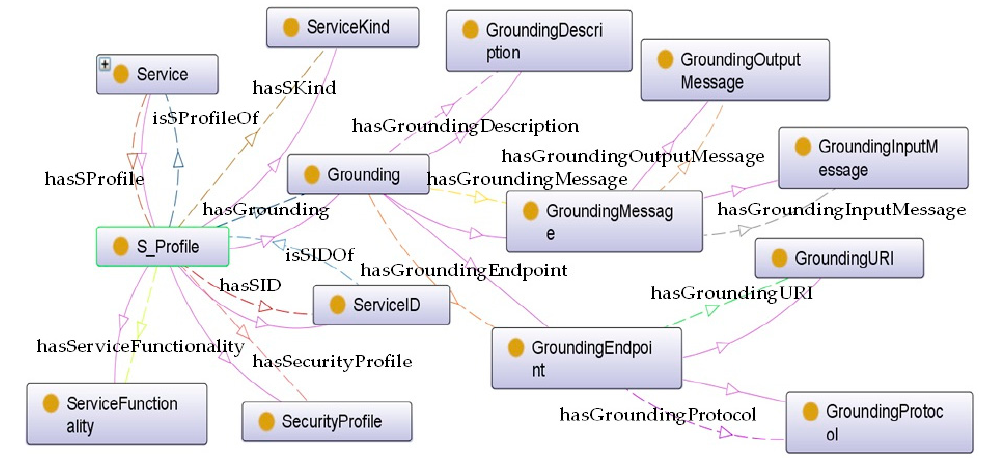
Figure 9. Internal structure of S_Profile.